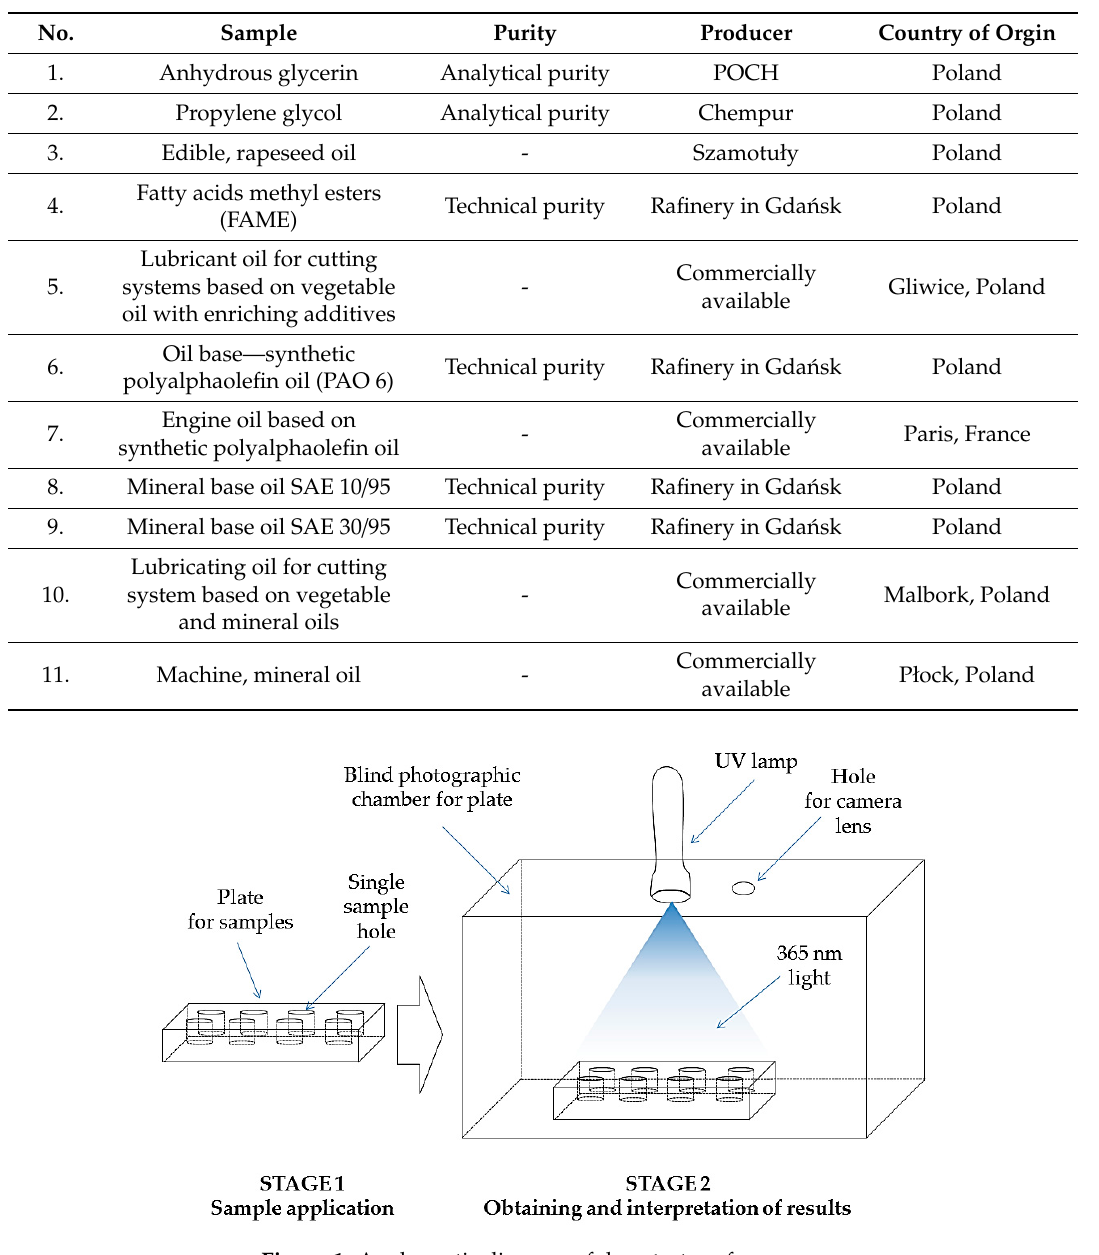
Figure 1. A schematic diagram of drop test performance.